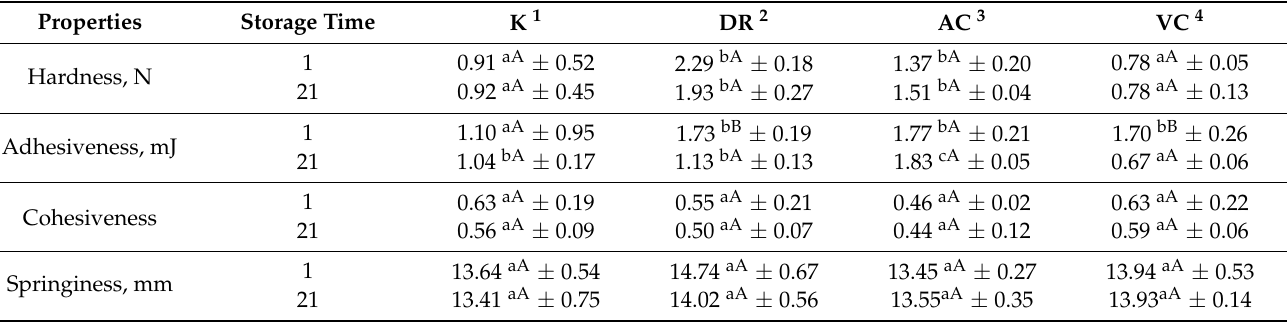
Table 3. Parameters of texture profile of milk fermented by Lactobacillus rhamnosus depending on the source of vitamin C.